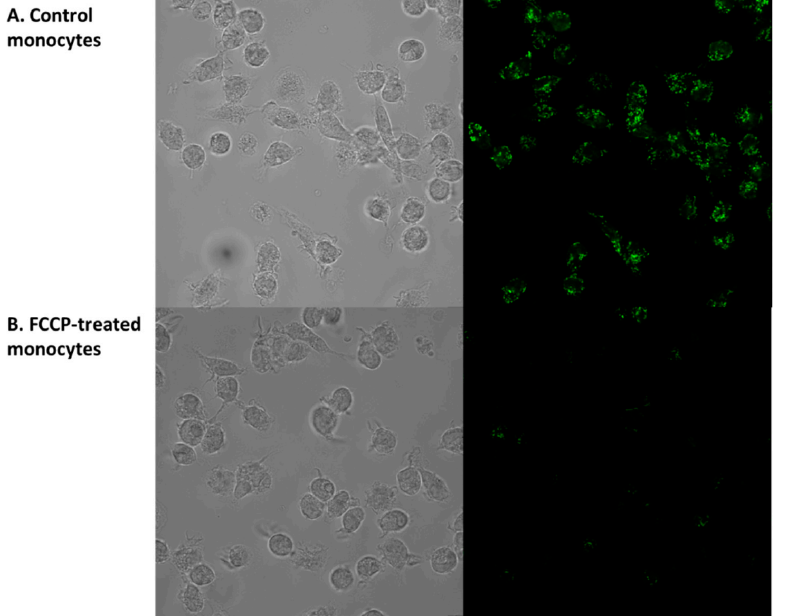
Figure A1. Monocytes were treated or not with 5 µ M of carbonyl cyanide 4-(trifluoromethoxy) phenylhydrazone (FCCP) for 30 min to remove mitochondrial potential, stained with MitoTracker, and visualized as described